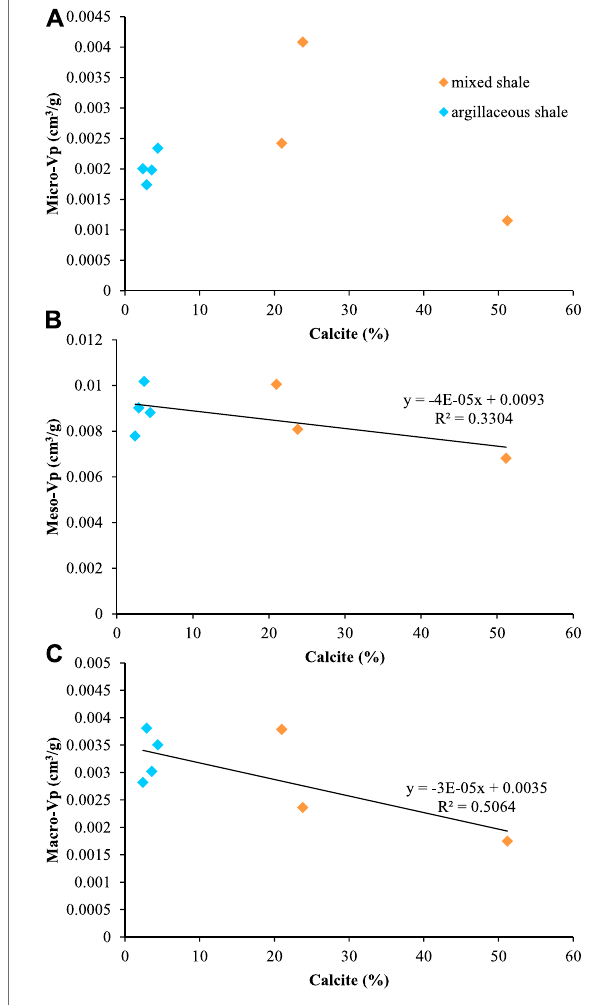
FIGURE 11 | Intersection diagrams of calcite and pore structure parameters. (A) calcite and micro-V p ; (B) calcite and meso-V p ; (C) calcite and macro-V p